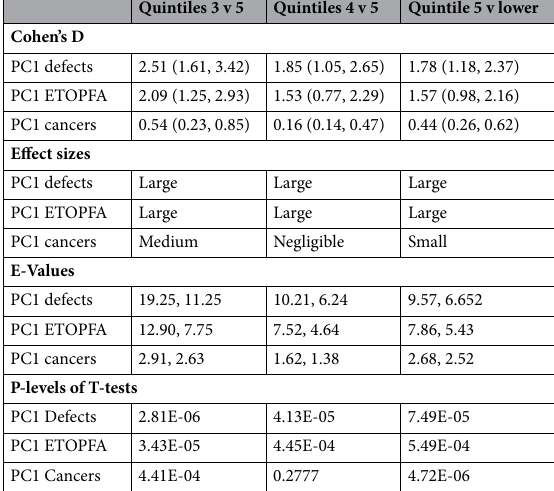
Parameter Estimate (C.I.)